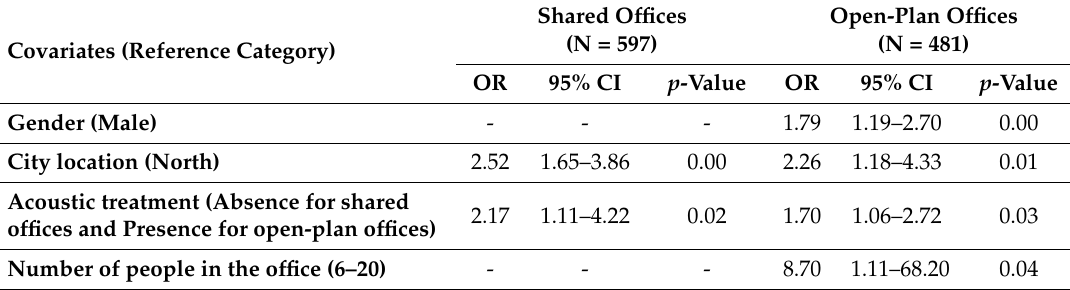
Table 7. Odds Ratio (OR) and 95% oconfidence interval (CI) of the covariates that significantly ( p -values < 0.05) affect noise annoyance in shared and open-plan offices according to the logistic regression